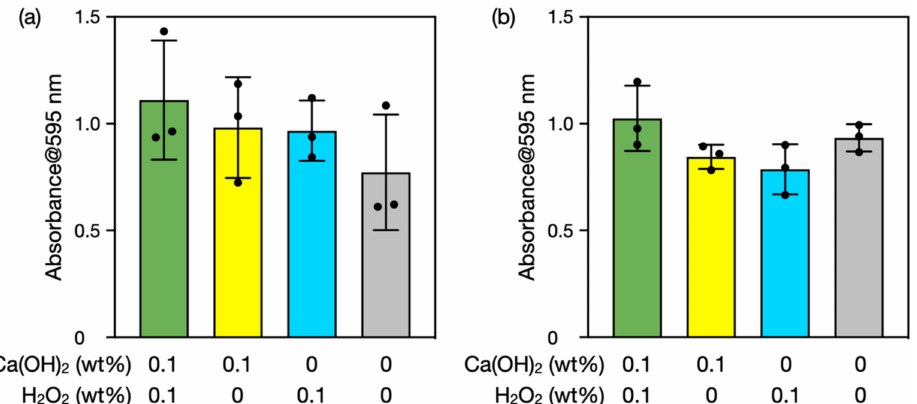
Figure 3. Semi-quantification of biofilms before and after the treatments with Ca(OH) 2 and/or H 2 O 2 for ( a ) 3 and ( b ) 30 min. The y -axis is the 595-nm absorbance of crystal violet extracted from the stained biofilms. The error bars represent the standard deviation of three individual